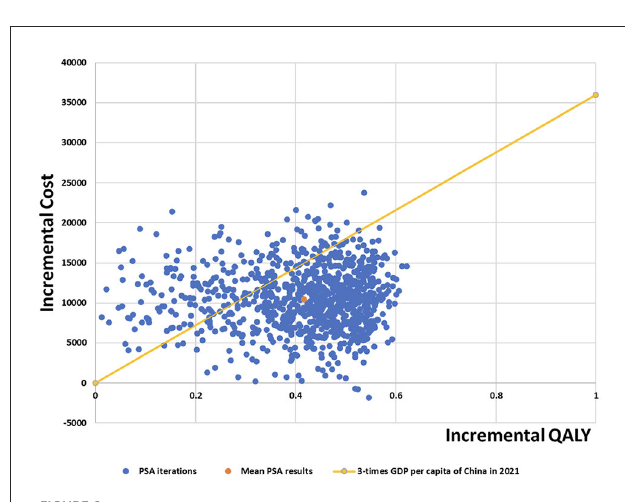
FIGURE6 Probabilistic sensitivity analysis scatter